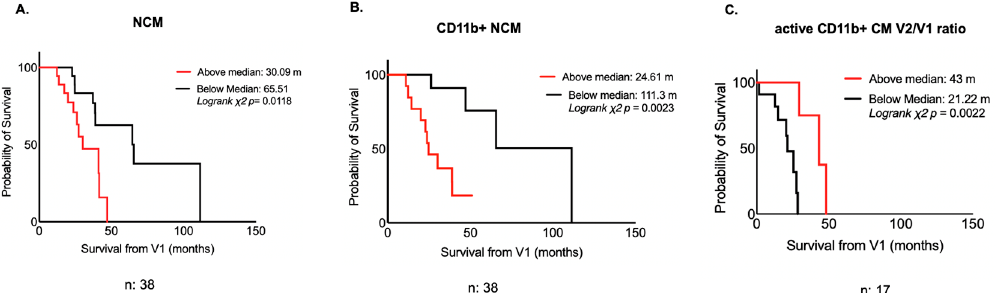
Figure 2. Blood monocyte frequencies and survival. Kaplan–Meier survival analysis shows a shorter survival for ALS patients with higher frequencies (above median) of NCM ( p = 0.0118) ( A ) and with higher frequency of CD11b+ NCM, ( p = 0.0023) ( B ). Higher V2/V1 ratios of active CD11b+ CM frequencies predict longer survival for ALS patients ( p = 0.0022) ( C ). Red lines indicate ALS subgroups with higher analyte levels (above median), and black lines ALS subgroups with lower level (below median). Log rank chi-square and p values as well as survival in months calculated for each subset of ALS patients are reported for each Kaplan–Meier figure. p -value was obtained from log rank test chi-square. Survival is calculated from V1.